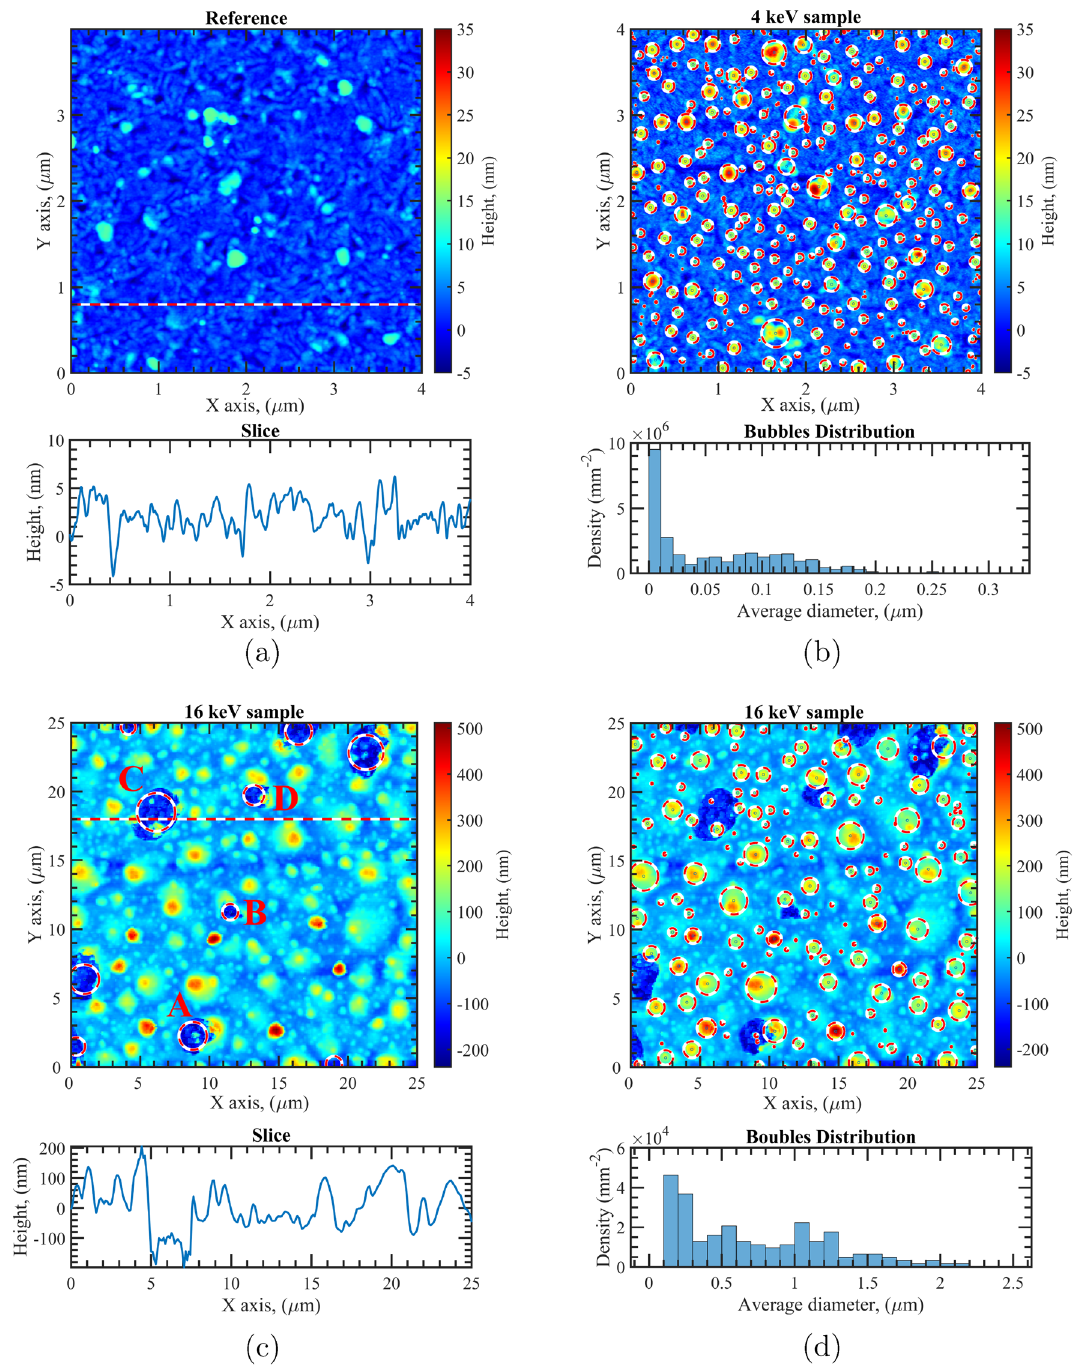
Figure 6. AFM images of the reference ( a ), the 4 keV-irradiated sample ( b ) and the 16 keV-irradiated sample ( c , d